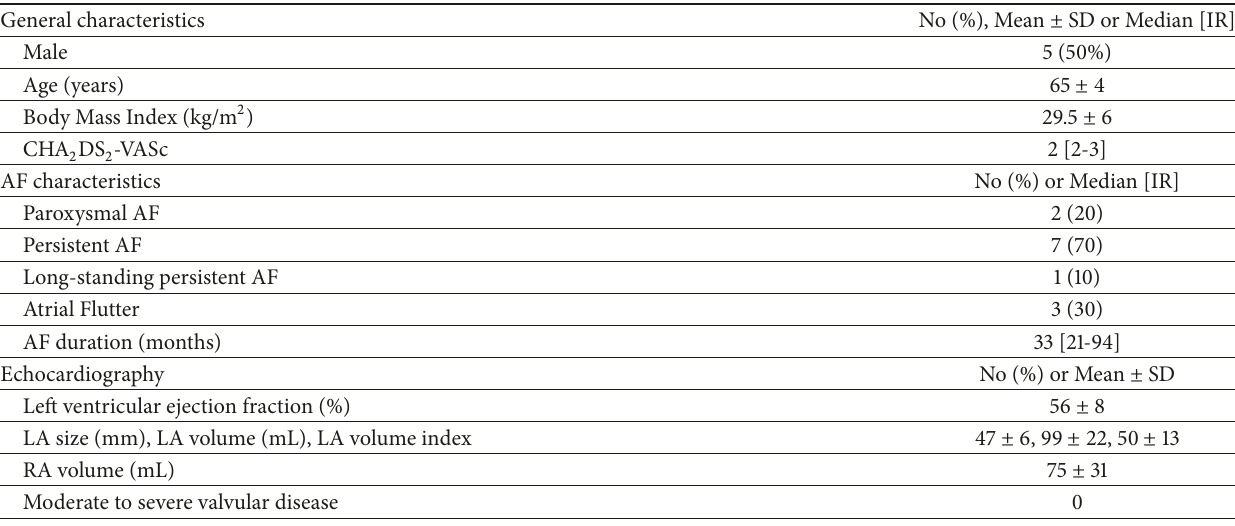
Table 1: Patient